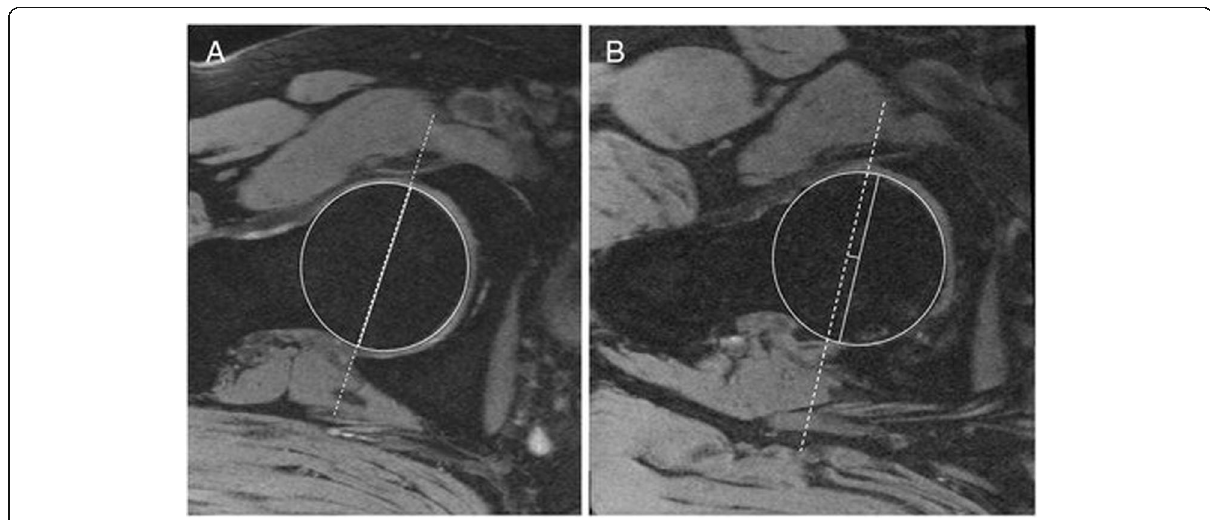
Fig. 3 a A line joining anterior and posterior bony rim-do not include labrum. This is the rim line (dotted). Then, b draw another line parallel to the above that passes through the center of the head. This is the center line. Normally rim line should be lateral to center line (measure in mm with a +